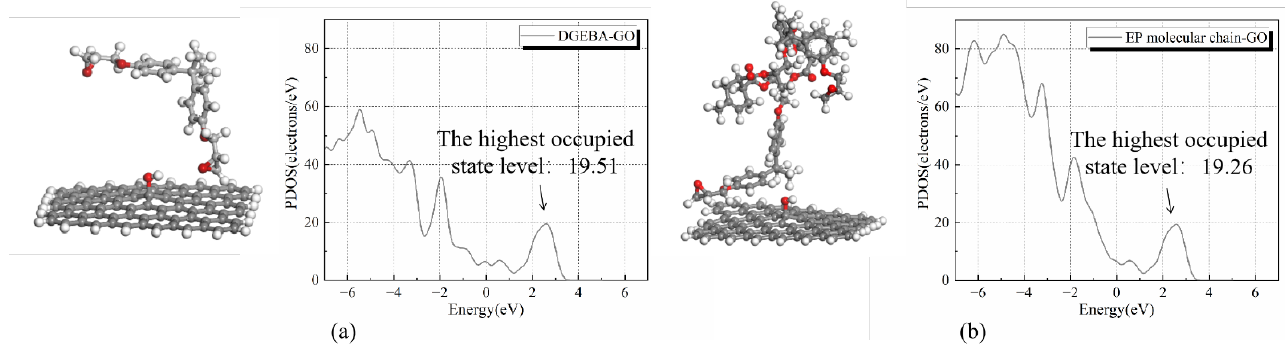
Figure 4. The PDOS distribution of interfaces in EP/GO: ( a ) interface 1-DGEBA and GO; ( b ) interface 2-EP molecular chain and GO.